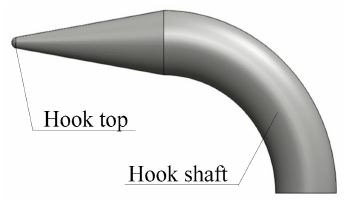
Figure 2. Microhook.